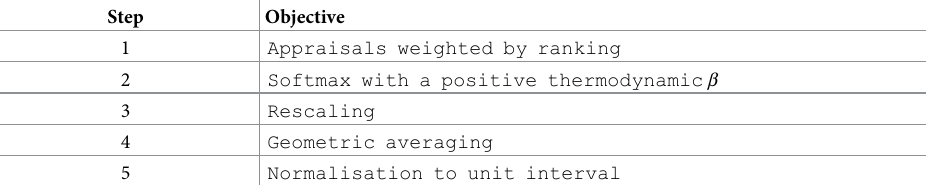
Table 2. EA 3 algorithm structure with objectives described for each